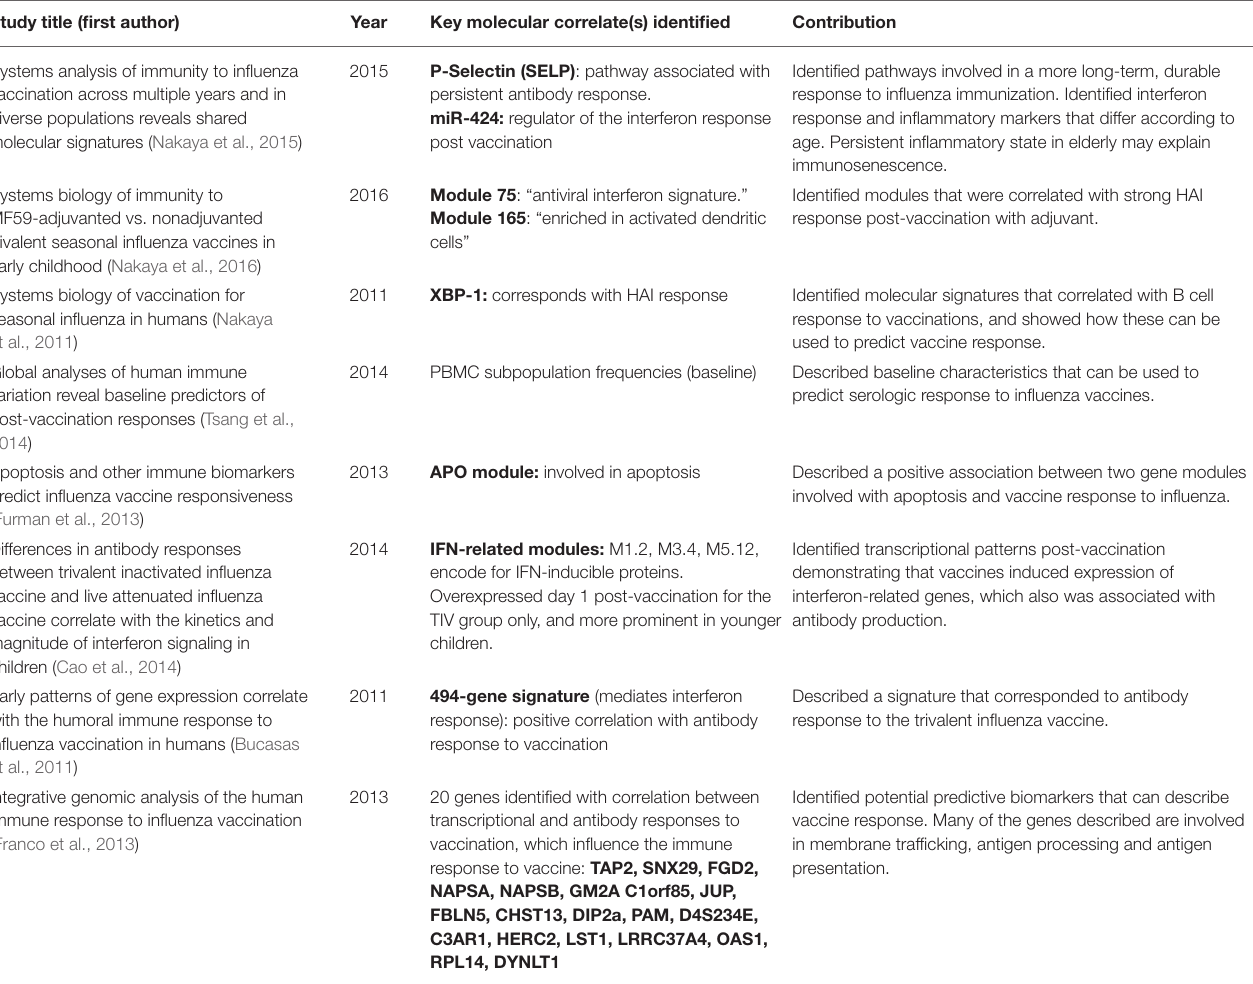
TABLE 2 | Using systems biology to study immune responses to influenza